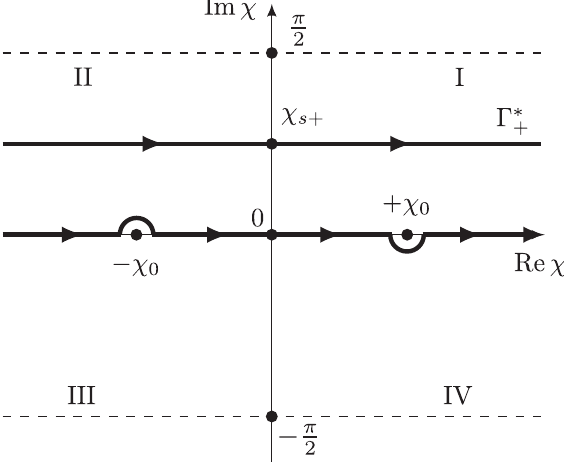
2. The complex plane k x : the integration path (real axis), the poles (cid:3) k x 0 , the branch points k x 1 ; 2 , and the cuts. The quadrants of the physical sheet of the complex plane k x are marked by roman